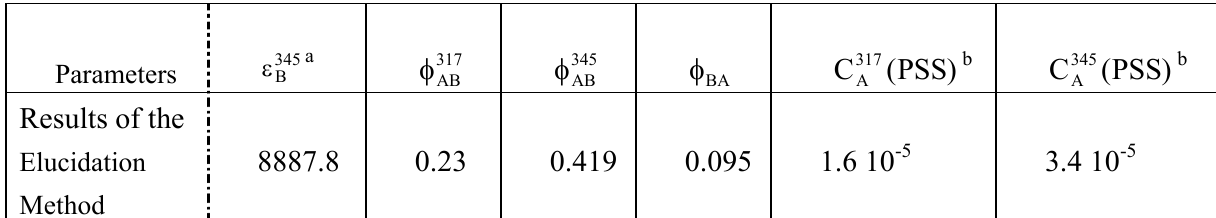
Table 5. Calculated and experimental spectroscopic and kinetic values for the unknown parameters of the